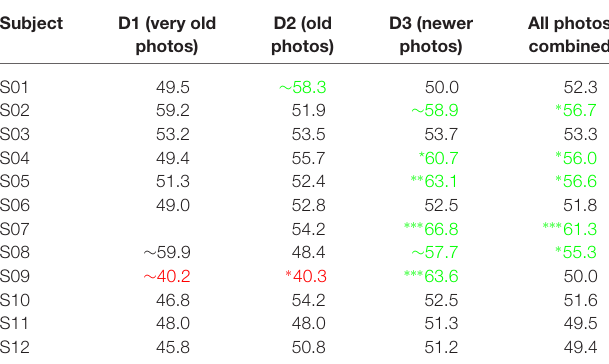
TABLE 1 | Behavioral results for the 12 subjects in the 3